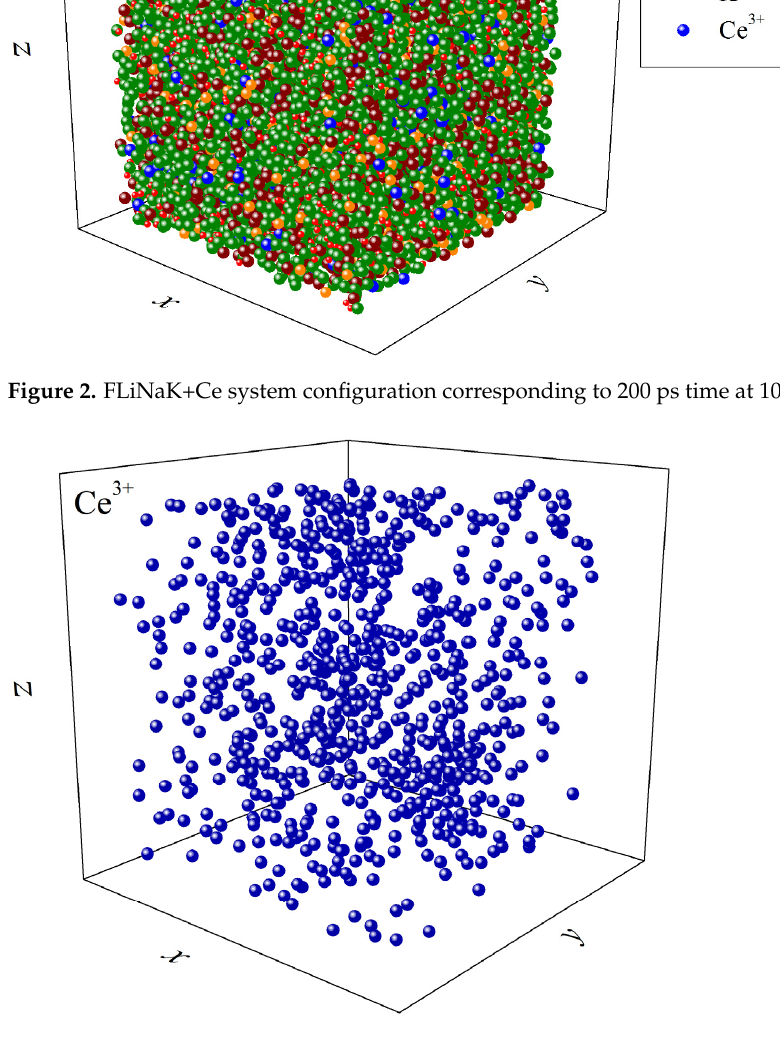
Figure 4. Simulated and experimental densities of FLiNaK system; dash line shows the linear fit of our MD data; blue triangles show results of experiment [28], pink dots represent the simulated data obtained in the polarizable MD model [29]. 3.2. Self-Diffusion of Ions The values of the self-diffusion coefficients of Li, Na, K, F, and Ce ions at different temperatures are presented in Table 2. In addition to the D values for the FLiNaK+CeF 3 system, the values of the D coefficients for pure FLiNaK calculated by us as well as those obtained from the experiment [30] are also shown here. The experimental values of D de- termined at temperatures not exceeding 936 K are presented at two temperatures (800 and 880 K). According to our calculations, both for pure FLiNaK and for the FLiNaK+CeF 3